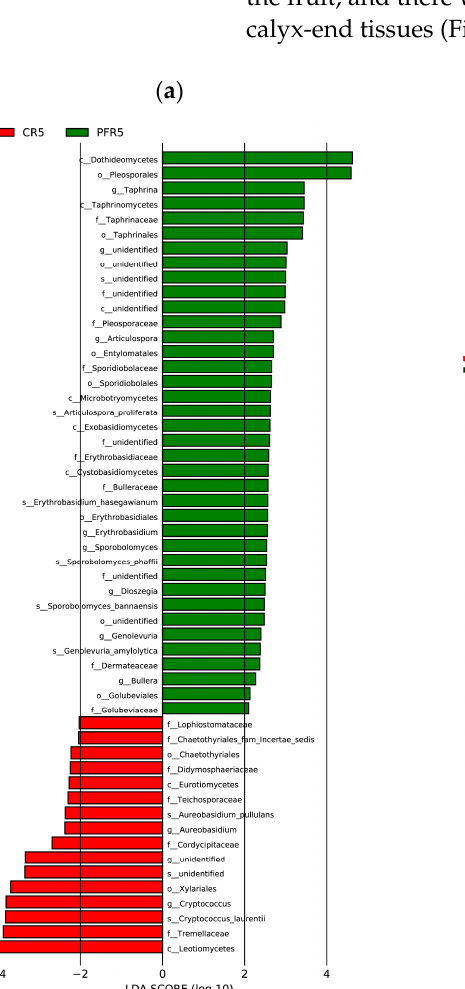
Figure 7. LEfSe analysis illustrating the differences in the relative abundance of taxa of calyx-end and peel tissues of bagged apple fruit. ( a ) The linear discriminant analysis (LDA) histogram exhibits biomarkers of fungal microbiota of bagged apple fruit. The histogram shows 54 taxonomic clads of fungal taxa with significant differences (cut-off score ≥ 2.0). ( b ) The cladogram with significantly discriminant taxon nodes colored. Red and green circles mean that the taxa showed differences in relative abundance, and yellow circles mean non-significant differences; branch areas are shaded according to the highest ranked group for that taxon.